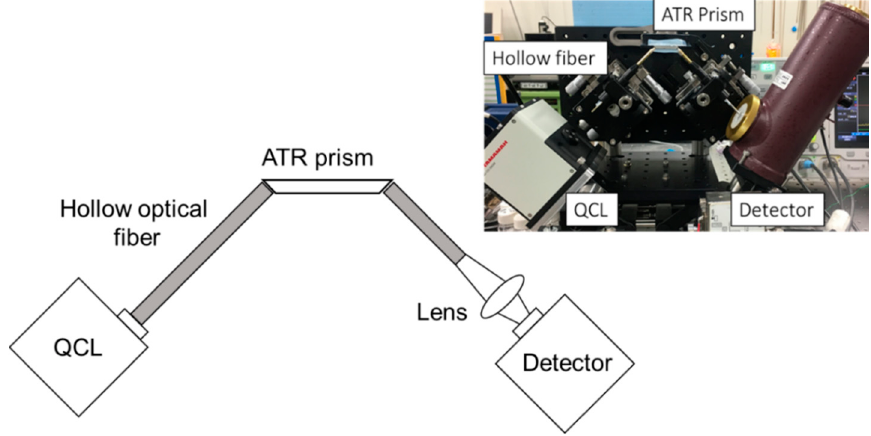
Figure 1. Schematic and appearance of the attenuated total reflection (ATR) measurement system using the quantum cascade laser